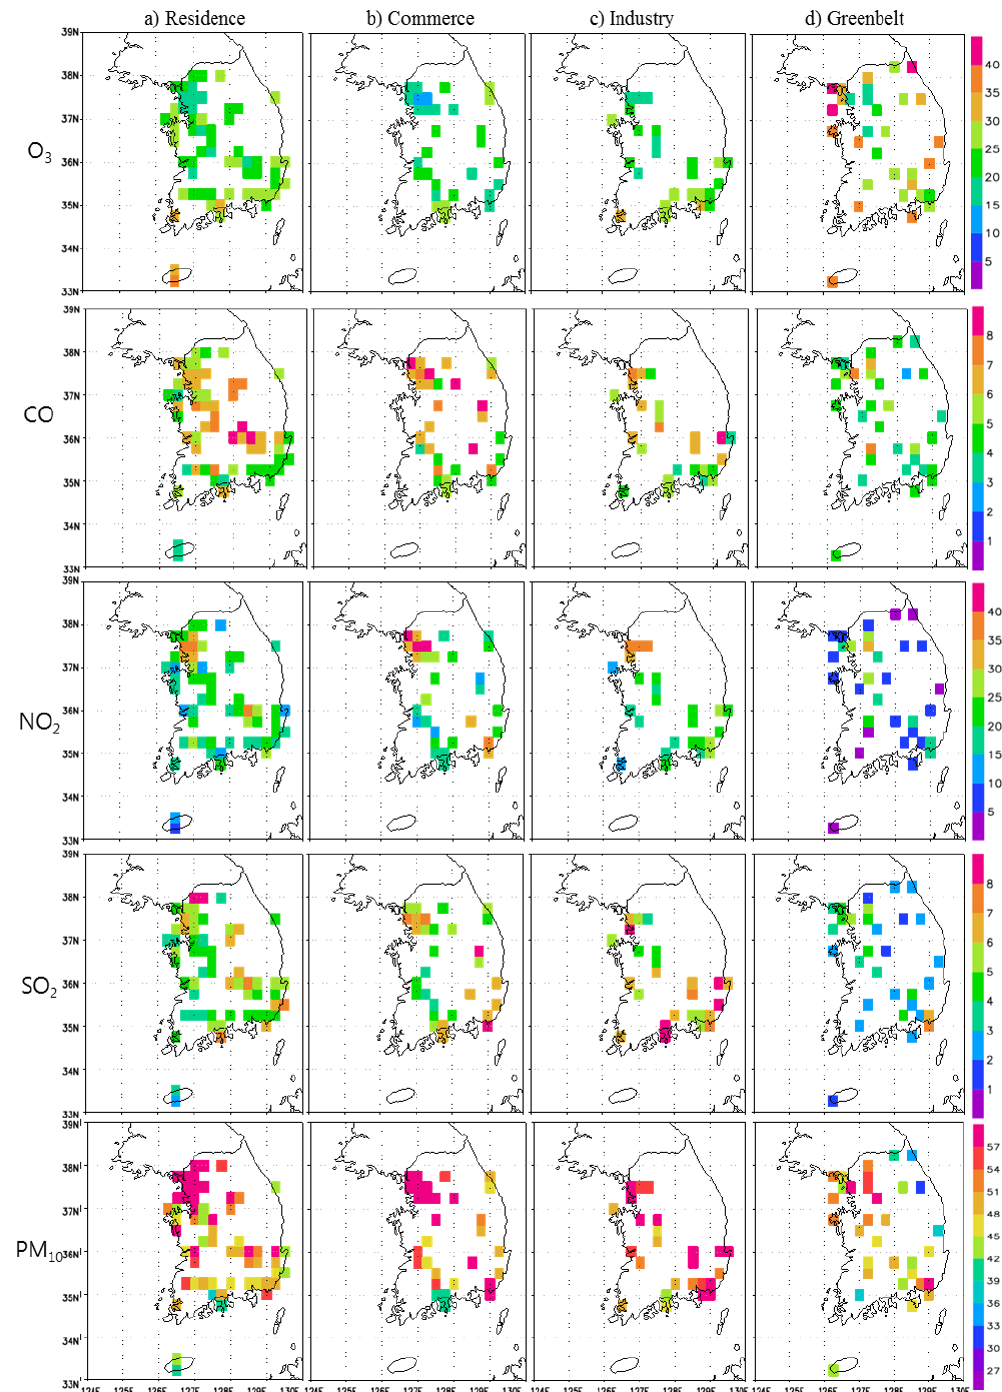
Figure 5. Climatological annual averages in a 0.25 ◦ × 0.25 ◦ grid over South Korea during 2002–2013 of the surface air pollutant observations of O 3 (ppb), CO (0.1ppm), NO 2 (ppb), SO 2 (ppb), and PM 10 (µgm − 3 ) under the MEK four land-use types of (a) residence, (b) commerce, (c) industry, and (d)